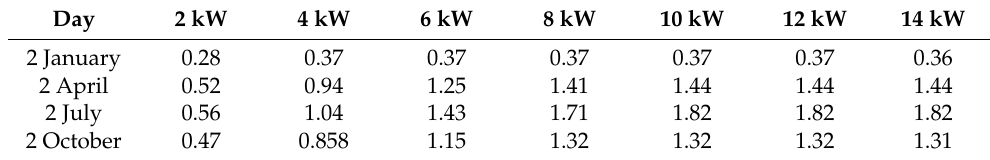
Table 5. Daily hydrogen production (kg) by an electrolyzer at several capacities for selected